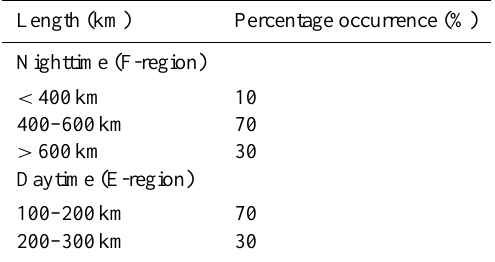
Table 1. Sub-ionospheric horizontal extent of mid-latitude scintil- lations. Percentage occurrence is defined as the ratio of the number of passes with scintillations to the total number of passes recorded, expressed in